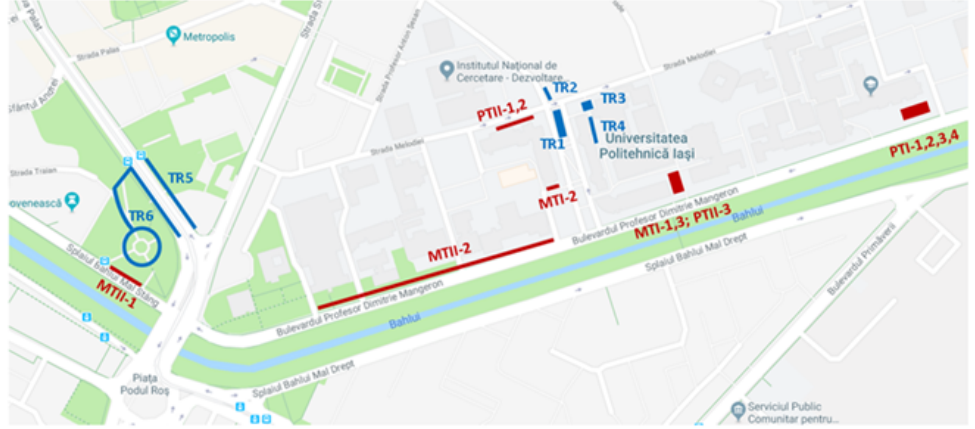
Figure 2. Geographical localization of the environments used for training and